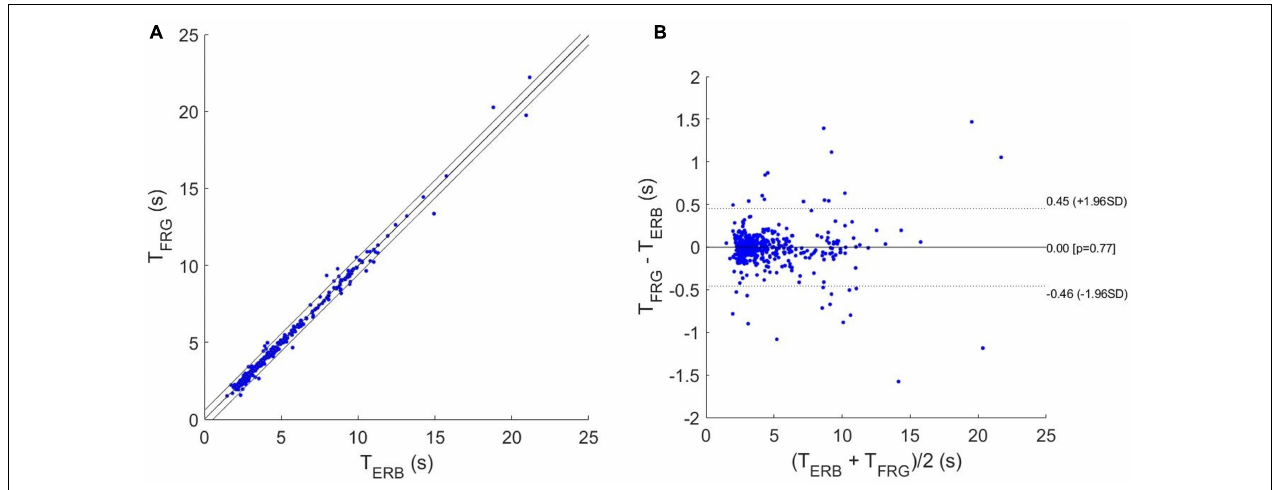
FIGURE 7 | Statistical analyses on inter-breath intervals estimated from ERB and FRG: (A) results of regression and correlation analyses; (B) results of Bland-Altman analysis.